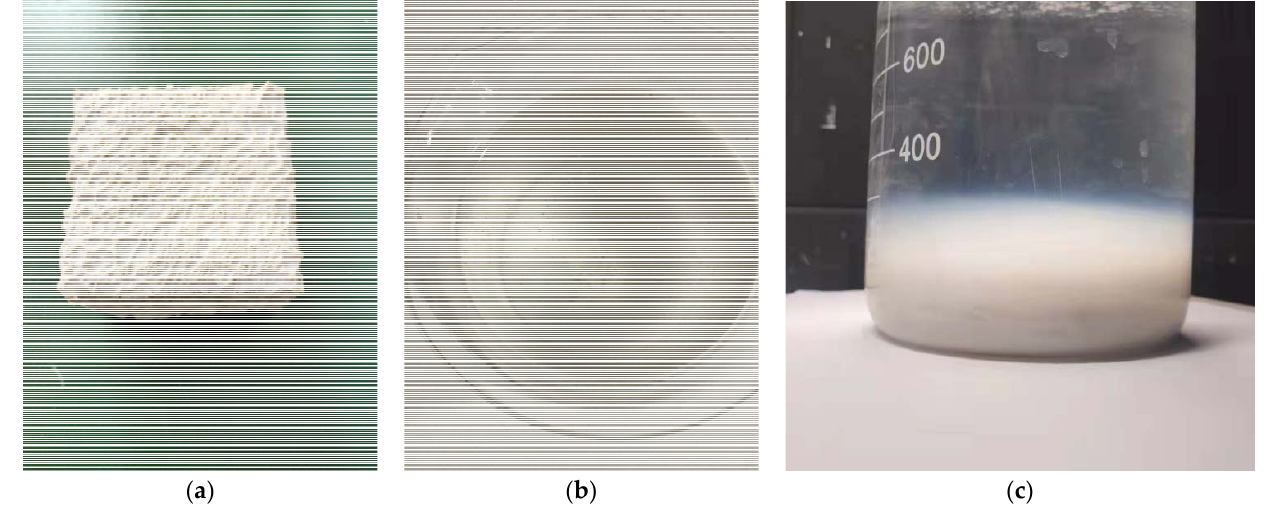
Figure 10. Alkali ‐ activated ordinary metakaolin specimen before immersion ( a ), after immersion for 3 days ( b ) and 10 days ( c ). 3 days ( b ) and 10 days ( c